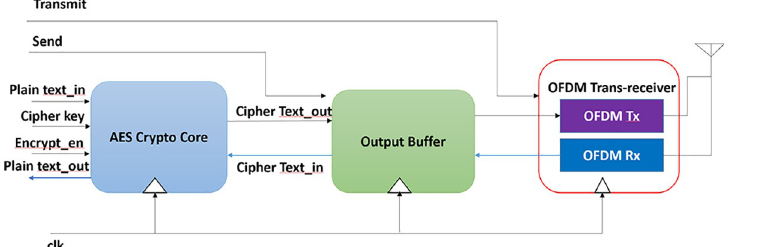
Fig 3. System level block diagram of proposed wireless AES crypto